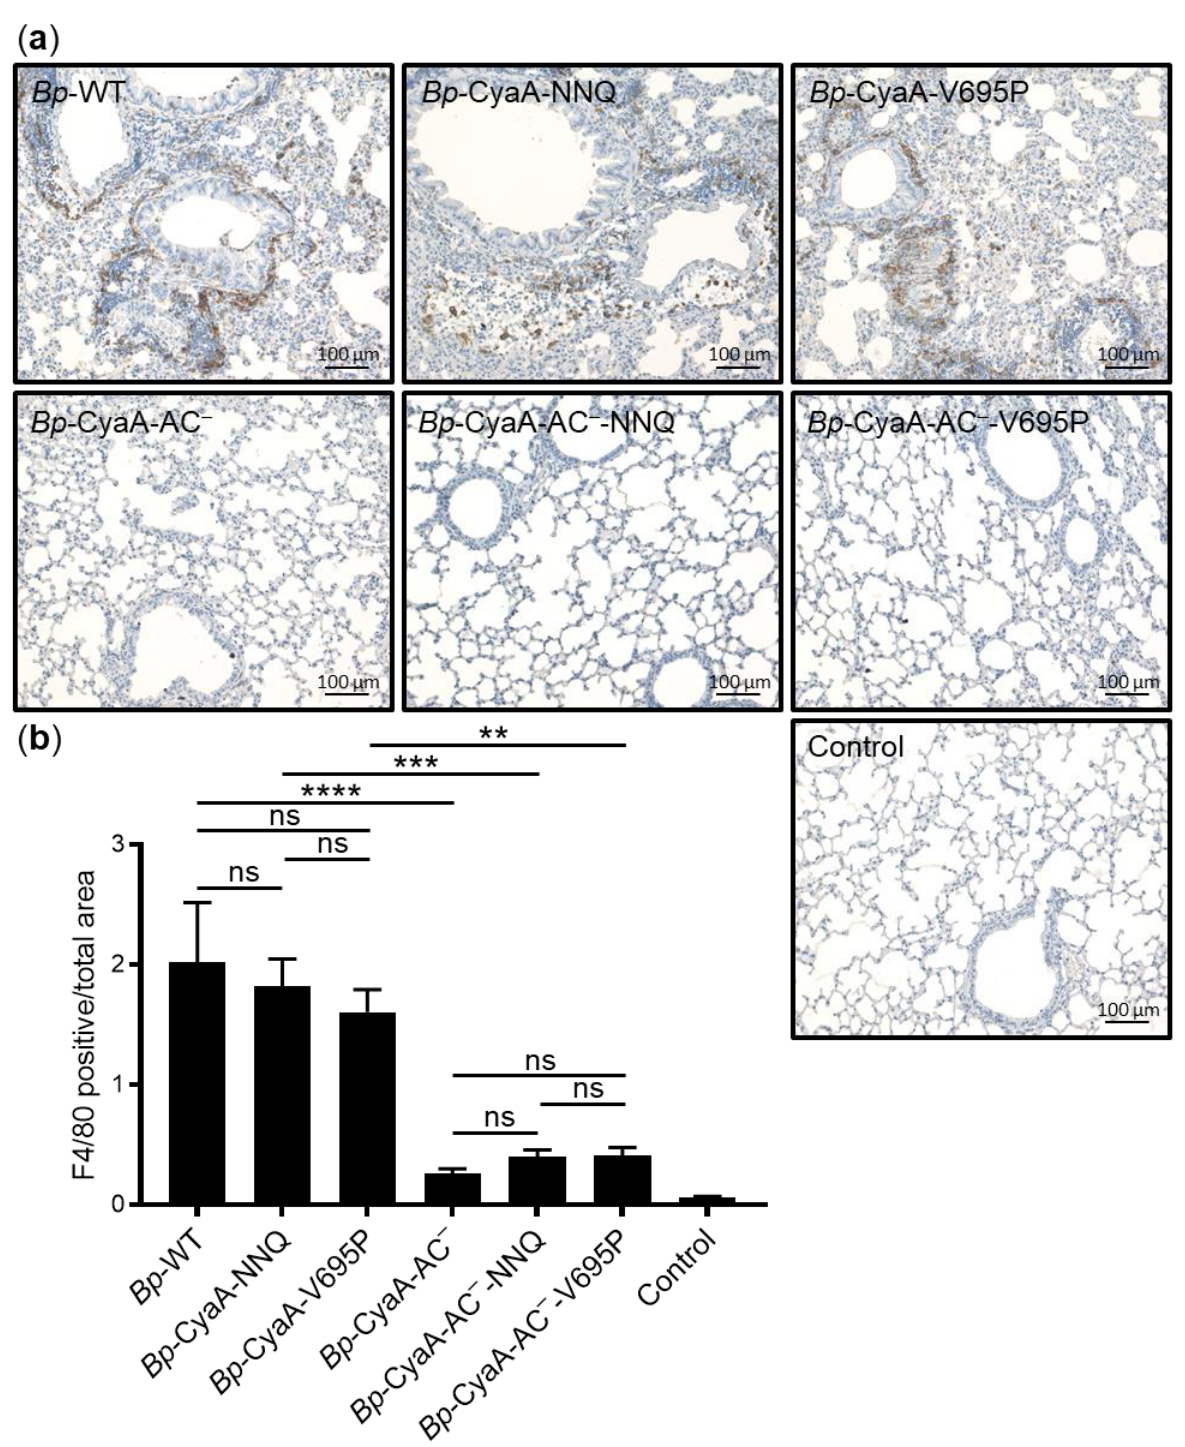
Figure 5. Selective enhancement of the pore-forming activity of CyaA does not affect macrophage recruitment into B. pertussis infected lungs. Three BALB/cByJ mice per group infected intranasally with 2 × 10 5 CFU of the WT and mutant B. pertussis strains were sacrificed on day 7 and the sections of lung tissue were examined upon F4/80 immunohistochemical staining for macrophages. ( a ) Representative lung sections were inspected by light microscopy at a magnification of 10×